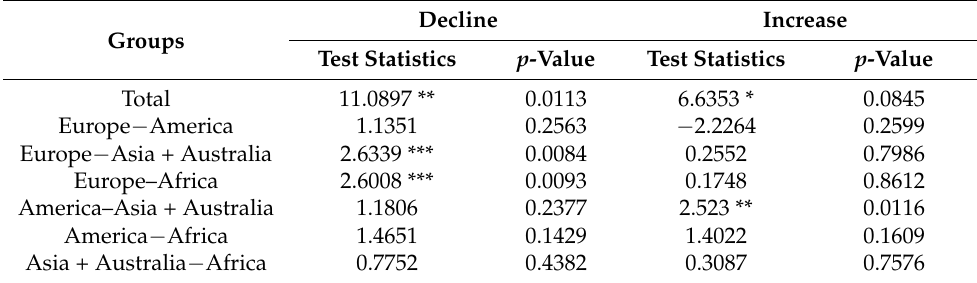
Table 2. Results of the Peto–Peto test ( N = 108). Source: own elaboration,